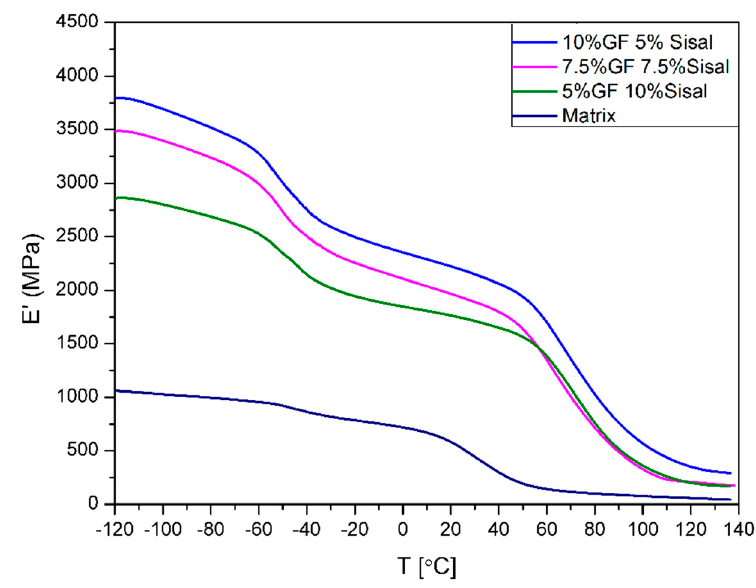
Figure 9. Storage modulus values of obtained hybrids.